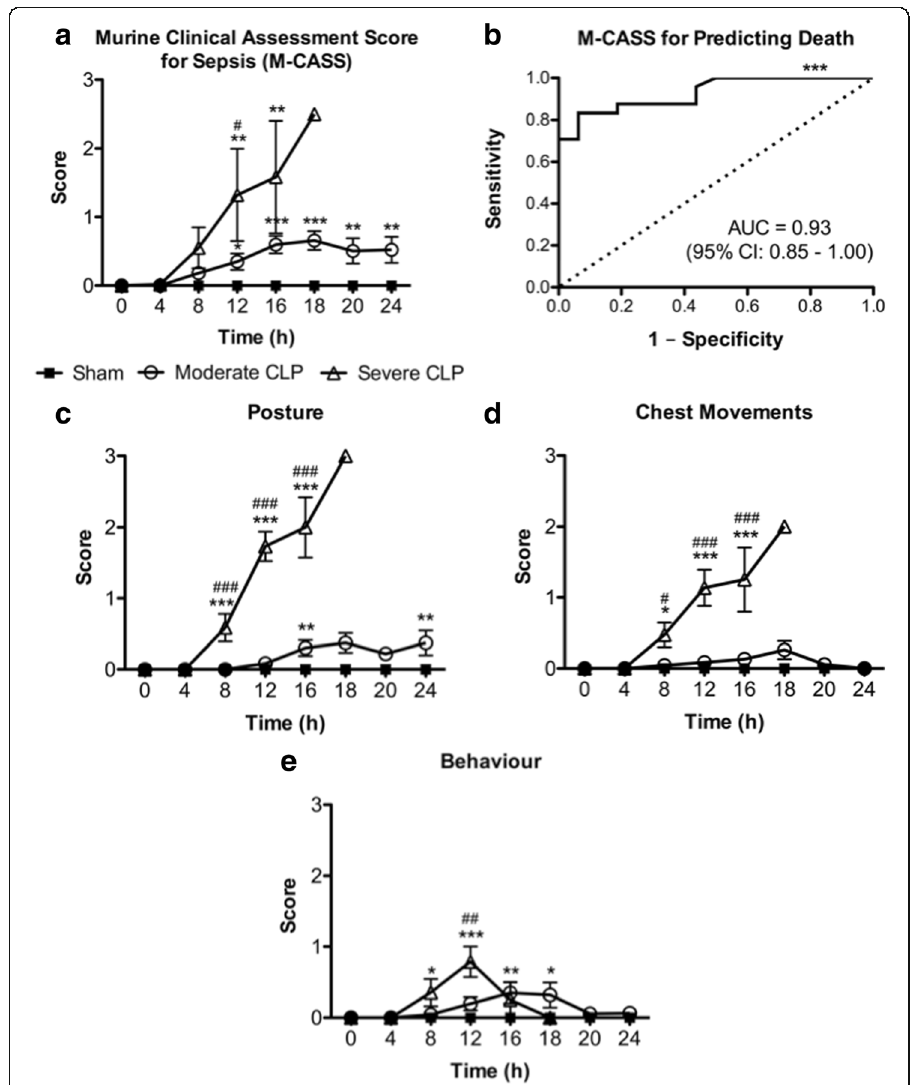
Fig. 4 Modified Mouse Clinical Assessment Score for Sepsis (M-CASS) over time ( a ), M-CASS score as a predictor of death in septic mice ( b ), and individual M-CASS component scores ( c – f ) over time in mice undergoing moderate or severe CLP. Data are presented as mean ± SEM from six independent experiments representing a total number of n = 18 sham, n = 23 moderate CLP, and n = 17 severe CLP mice; * p < 0.05, ** p < 0.01, *** p < 0.001 vs. sham (or vs. line of identity in ( b )); ### p < 0.001 vs. moderate CLP, by two-way ANOVA. Note: Only two mice undergoing severe CLP survived past 18 h, therefore statistical comparisons were not performed at this time-point ( a , c – e ). Dotted line in ( b ) represents the line of identity for statistical comparison in ROC analyses. Fur Aspect, Activity, and Eyelid component scores are identical to scores in Fig. 3c – e, respectively, thus are not shown again here, but are included as part of the overall M-CASS score. AUC area under the curve, 95 % CI 95% confidence